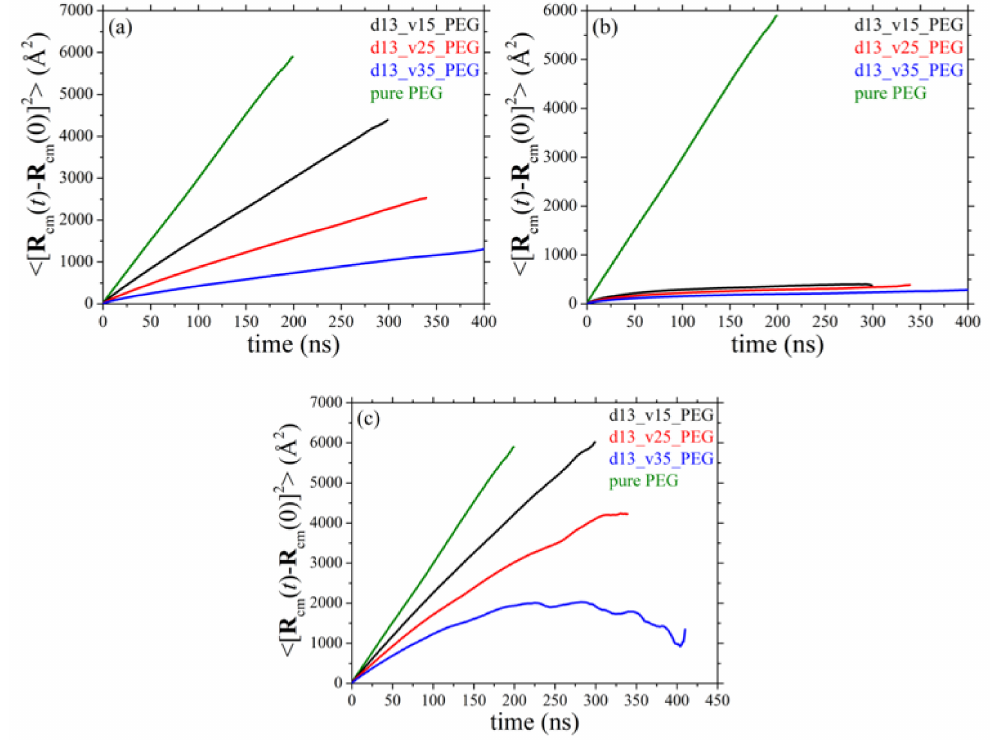
Figure 13. Same as with Figure 12 but for systems 1, 5, 6, and 7 (dependence on silica concentration). The explanation of ( a – c ) is the same as in Figure